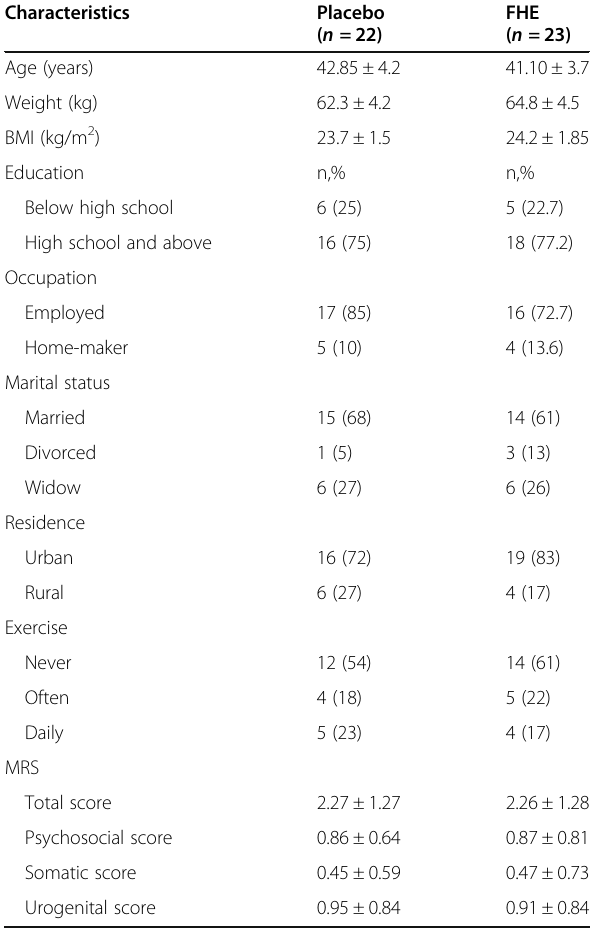
Table 2 Baseline demographic characteristics of